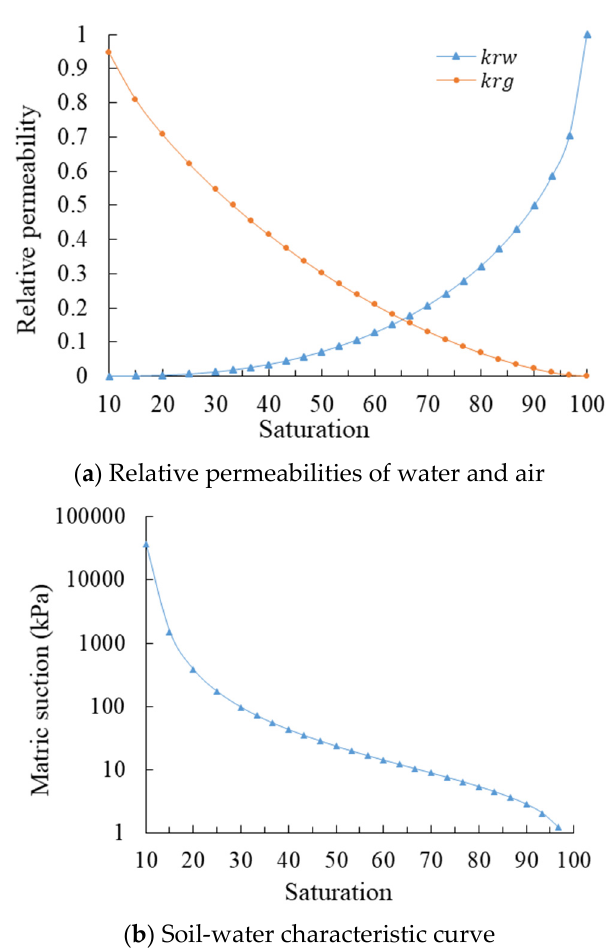
Figure 1. Hydraulic characteristics of the seepage